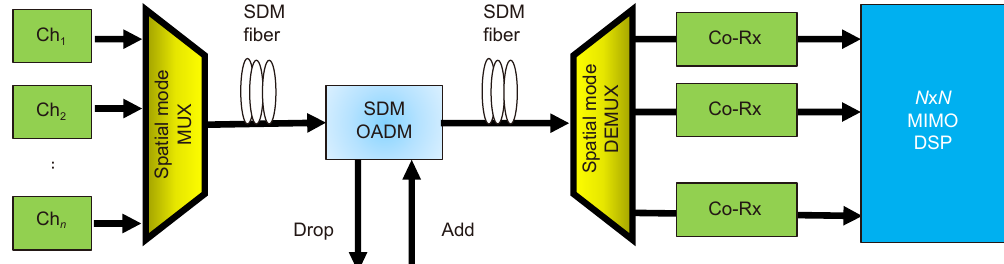
Fig. 7 | The design of an N x N SDM communication network using coherent MIMO digital signal processing. Where MUX/DEMUX repres- ents multiplexer/demultiplexer and Co-Rx signifies Coherent receiver.